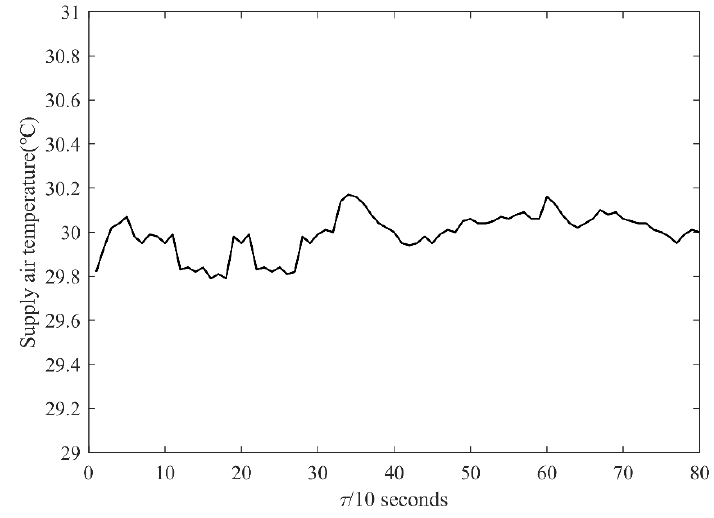
Figure 10. Supply air temperature control effect.